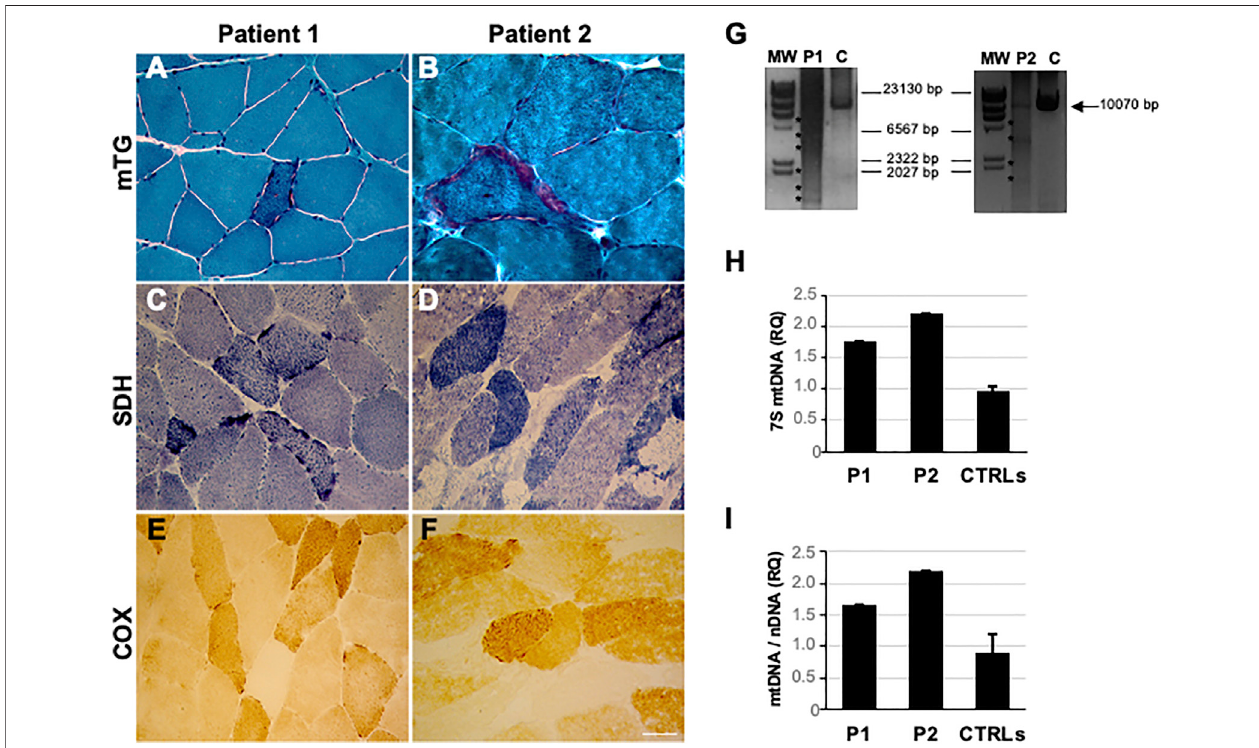
FIGURE1| Histologicaland mtDNA studies in RNASEH1 -mutatedpatients(P1 and P2). (A,B) Modi fi ed Gomori trichrome (MGT) showing thepresence ofragged red fi bersinpatients ’ musclesections. (C,D) SDHstainingshowedthepresenceofSDH-positive fi bers. (E,F) COXhistochemicalreactiondocumentingthepresenceof COX-negative fi bers. Magni fi cation 40x. Scale bar 50 μ m. (G) Long-range PCR analysis of mitochondrial DNA obtained from the probands ’ muscle biopsy (P1 and P2) andhealthycontrols(C).AsterisksindicatemultiplebandscorrespondingtomultiplemtDNAdeletions.Theblackarrowindicatestheexpectedsizeofthewild-type PCRamplicon(10.5 kB:FOR5635-RC16135).ThesizesofthebandsoftheDNAmolecularweightmarkerII(MW,Roche)areindicated. (H) Histogramshowinglevelsof muscle7SmtDNAinpatientscomparedtohealthycontrols(n=14).Theratio(RQ)indicates7SmtDNAlevelswithrespecttothetotalnumberofmitochondrialgenomes ampli fi ed by quantitative PCR. Error bars indicate standard deviations. (I) Histogram showing muscle mtDNA content in the proband compared to healthy controls (n = 27). mtDNA quanti fi cation, normalized to nuclear DNA (nDNA) content, was performed by quantitative PCR. Error bars indicate standard